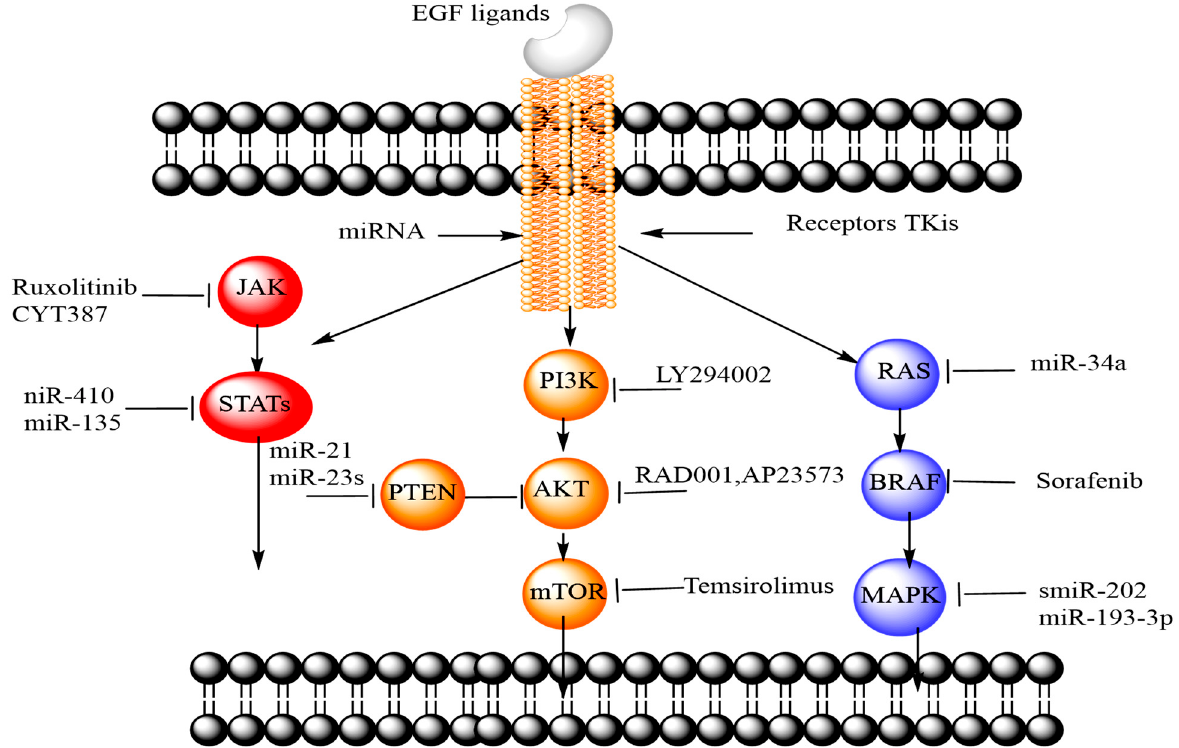
Figure 2. Oncogenic signaling pathways and drugs targeting abnormal signaling of EGFR, VEGFR, PI3/AKT/mTOR, RAS/BRAF/MAK, JAK/STAT pathways. Reproduced from the reference [27]. Table 1. Most common mutations in lung cancers and their relevant